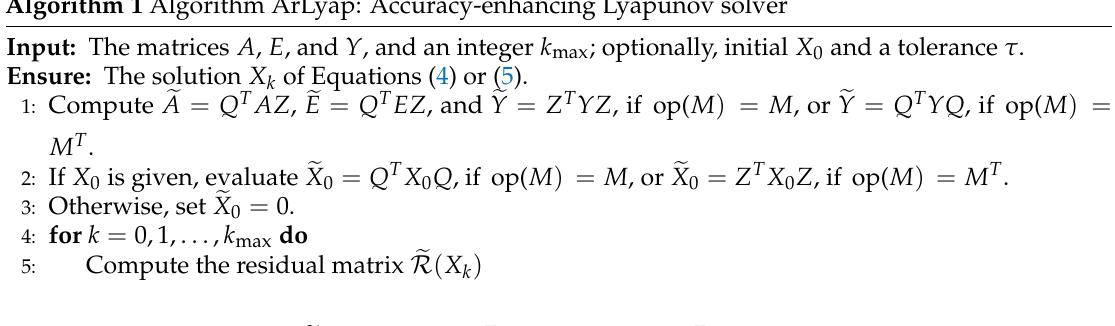
Algorithm 1 Algorithm ArLyap: Accuracy-enhancing Lyapunov